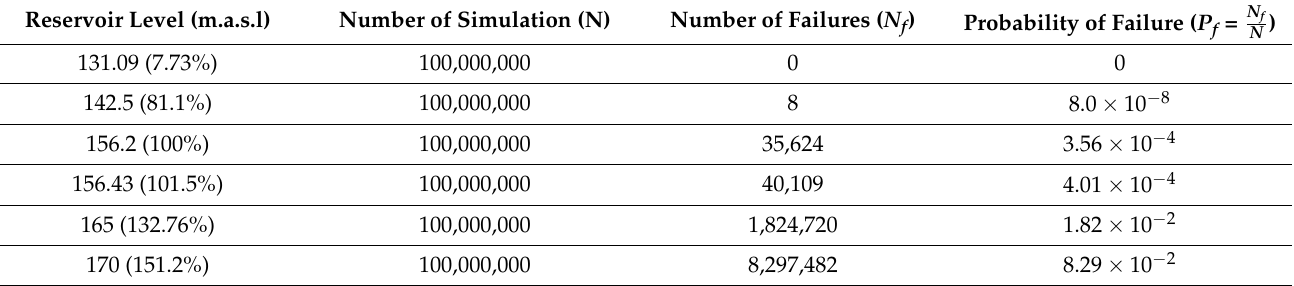
Table 5. Probability of failure for different reservoir